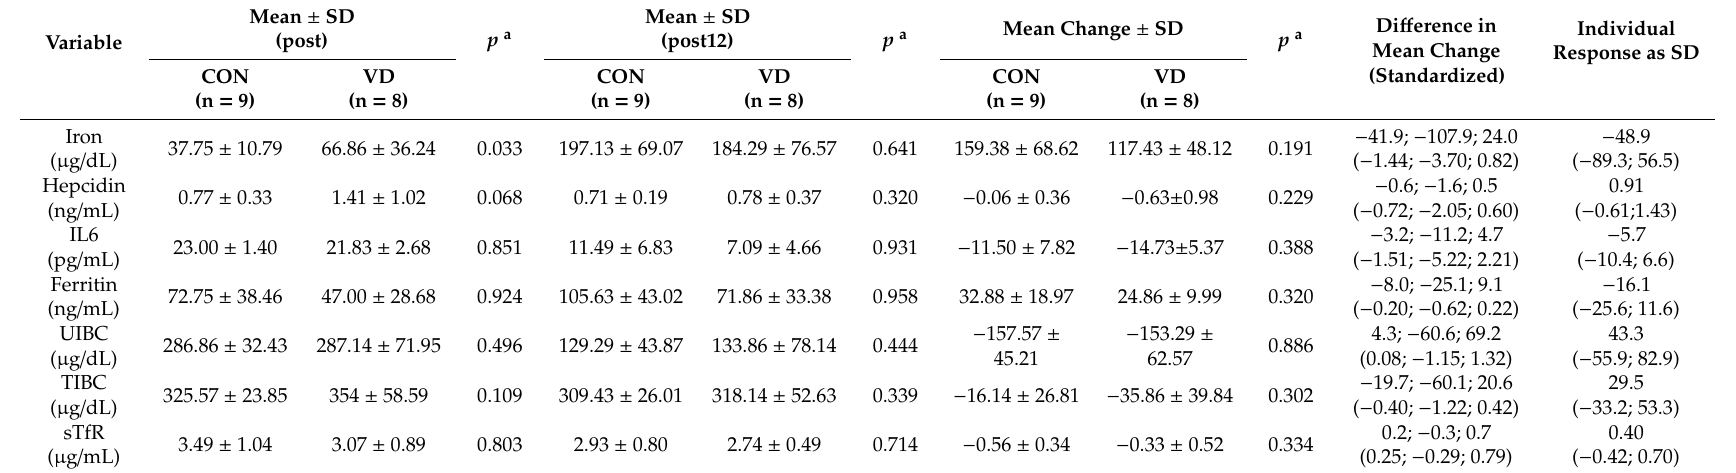
Table 3. The e ff ect of vitamin D 3 supplementation on exercise-induced changes in parameters of iron metabolism after the 100-km ultra-marathon (post) and 12 h after the run